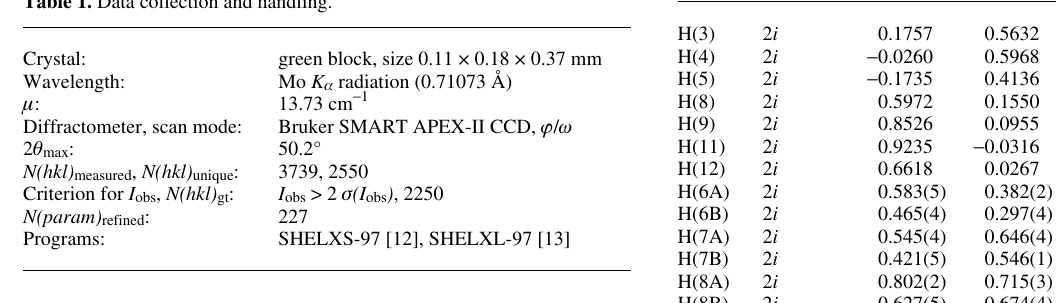
Table 1. Data collection and